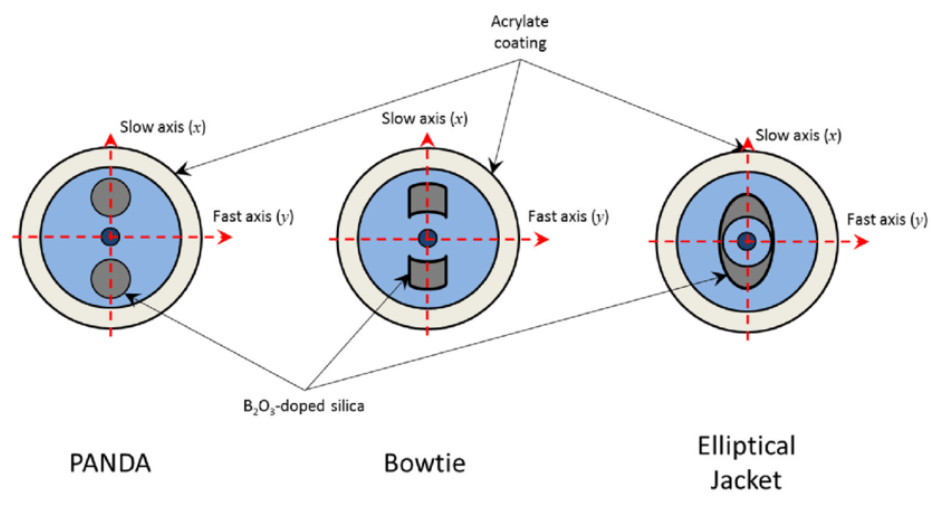
Figure 4. Examples of the most common types of PM fibers [34].